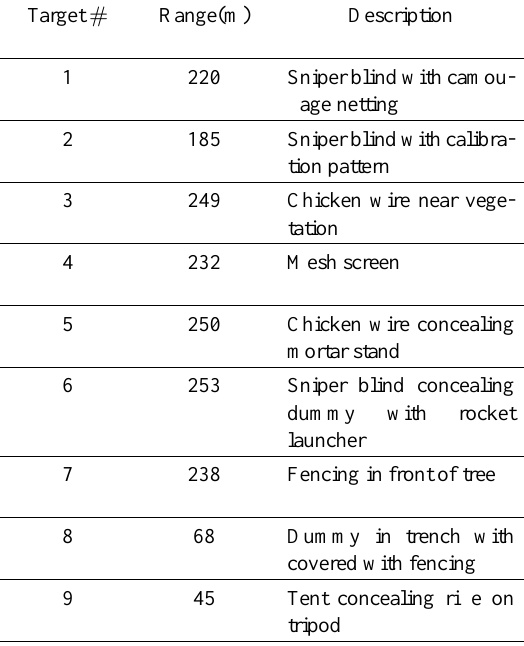
Table 2: Target descriptions and their ranges from the